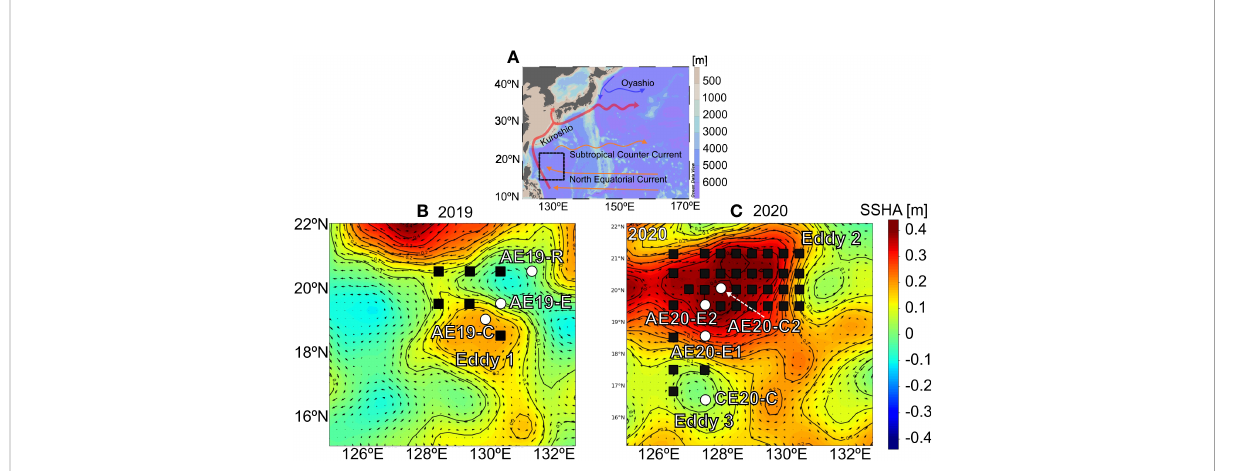
FIGURE 1 (A) Map showing the study region (black rectangle) and surface currents in the tropical northwest Paci fi c (modi fi ed from Gallagher et al., 2015). Blow-up map showing (B) the sampling stations (Eddy 1) in September 2019 and (C) sampling stations (Eddy 2 and Eddy 3) in September 2020. Circle (white) and squares (black) represent particulate and hydrography sampling, respectively. The background color shows the sea surface height anomaly (SSHA) averaged over the sampling period. The black arrows indicate the geostrophic